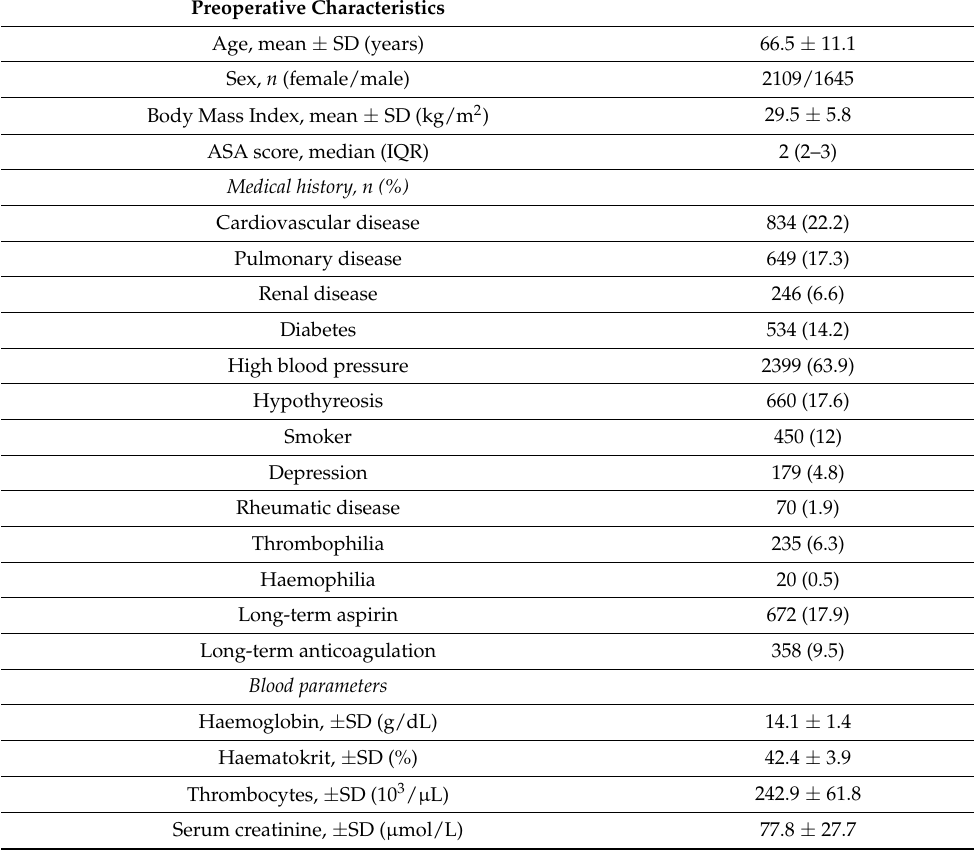
Table 1. Clinical